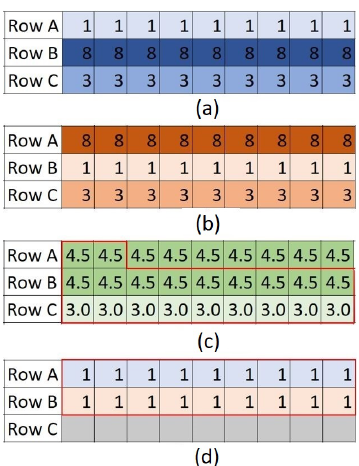
Figure 2. Suboptimality of FWLA method with multiple modes. Subfigures ( a , b ) are synthetic cost rasters for a highway and a power line, respectively. Subfigure ( c ) shows the weighted-average cost raster for the two modes. The two-cell-wide LCP found by FWLA is highlighted in a red box in subfigure ( c ). The optimal two-cell-wide LCP accounting for mode-specific lowest cost is shown in Subfigure ( d